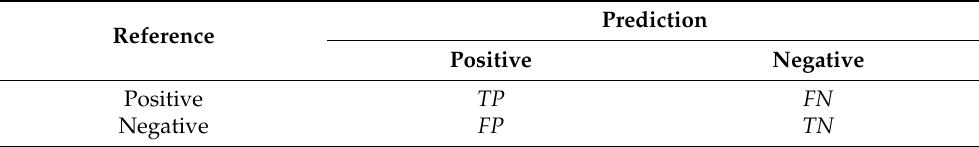
Table 4. Two-way decision confusion